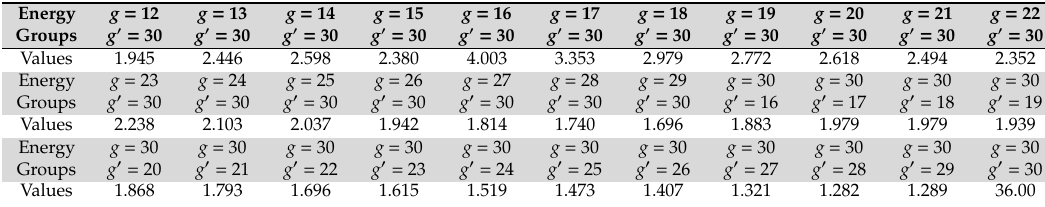
(cid:16) (cid:17) (cid:48) σ g , σ g , g , g (cid:48) = 1, ... ,30 having values greater than 1.0. t , i = 5 t , i = 6